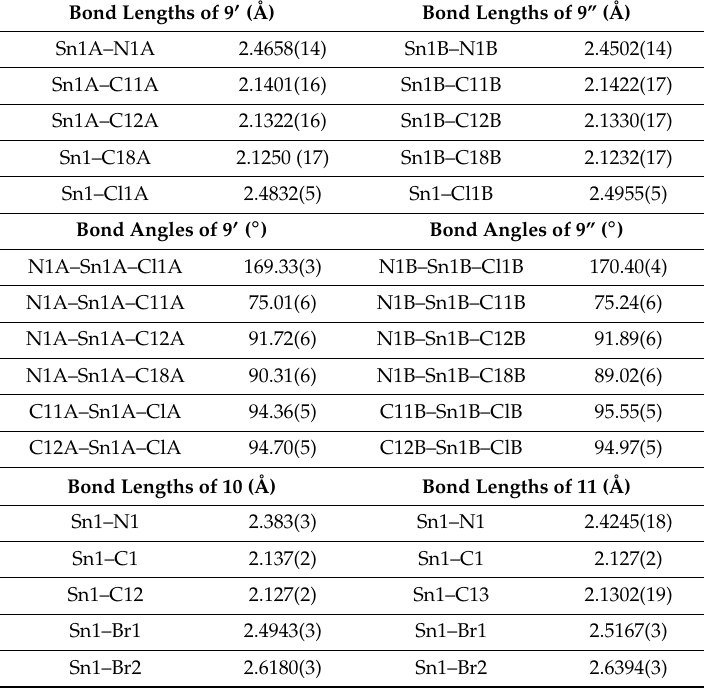
Figure 6. Displacement ellipsoid plots of the two crystallographically independent molecules of compound 9 (top: 9 ′ : left and 9 ″ : right) found in the unit cell and compounds 10 (bottom left) and 11 (bottom right). The C7–O1A–C8A–C9–N1 ring of 10 is disordered over two sets of sites. Thermal ellipsoids drawn at the 30% level. Table 2. Selected structural data for 9 , 10 , and 11 .